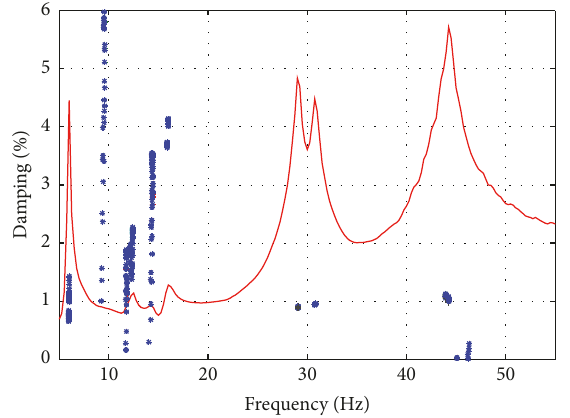
Figure 10: The door panel: stabilization diagram for the damping ratios: each “ ∗ ” corresponds to a pair natural frequency-damping